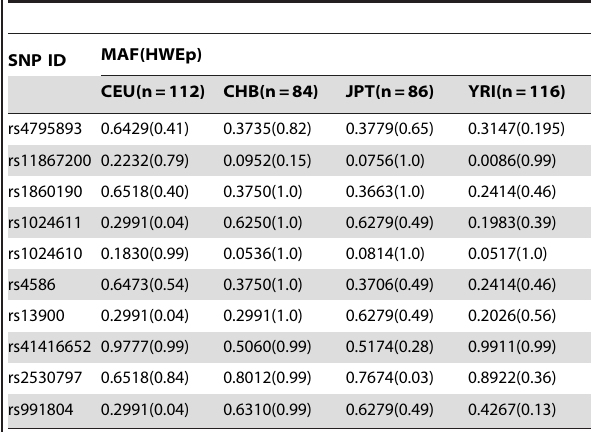
Table 3. Relative minor allele frequencies of CCL2 HapMap SNPs in different populations.